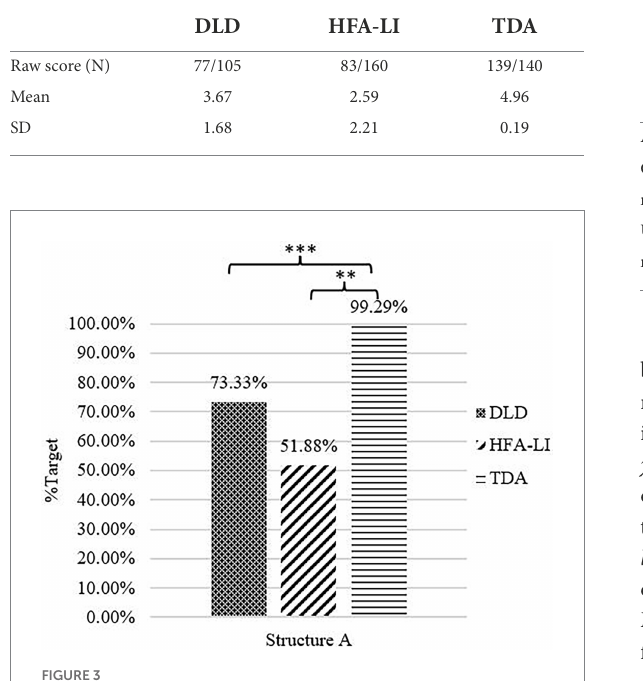
TABLE 3 Number of non-target responses in Structure A. TABLE 2 Descriptive statistics of the three groups in Structure